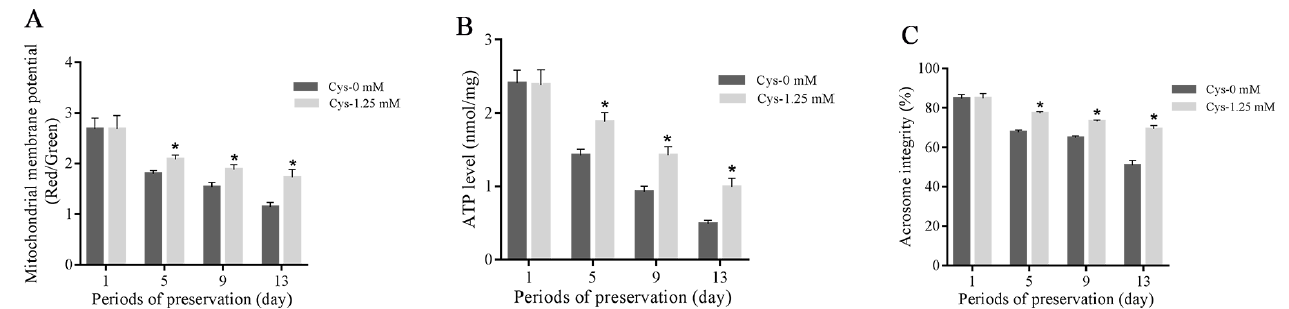
Figure 4. Effects of cysteine on sperm mitochondrial membrane potential (A), ATP level (B) and acrosome integrity (C) after 13 days’ preservation. Values are specified as mean± standard deviation (SD). Cys, cysteine. * Denotes significant differences compared with the control (p<0.05).